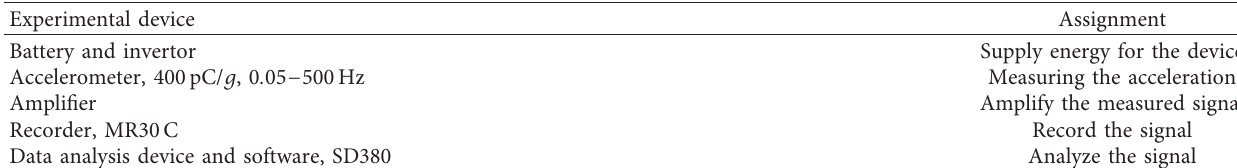
Table 9: Experimental devices.